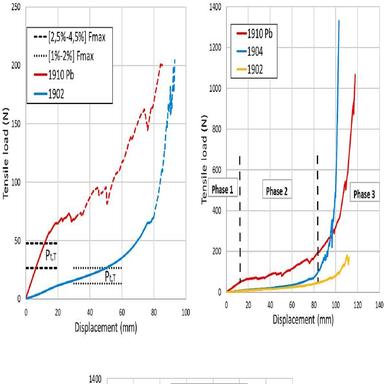
Representative example of the behavior curves of corrugated panels and measurements of their properties, as well as the behavior curves of ten 1910Pb panel samples under transverse tension loading.